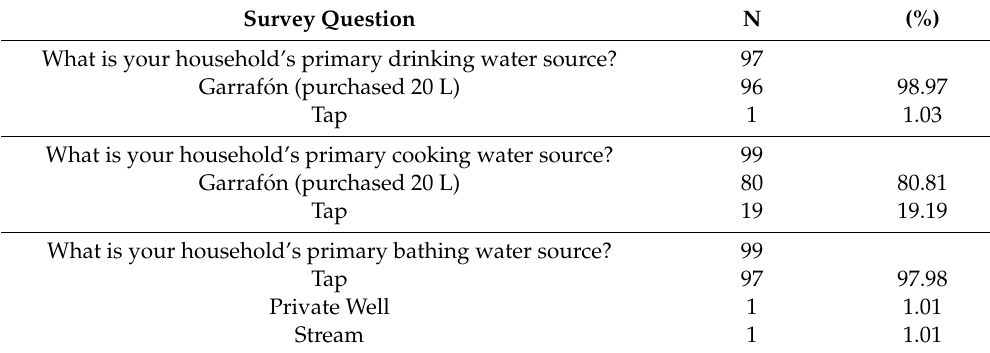
Table 3. Household primary water source and water use